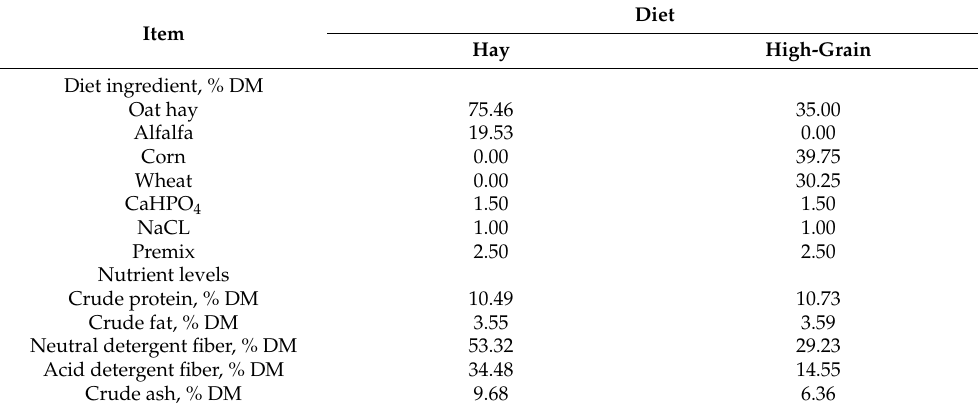
Table 1. Ingredient and nutrient composition of the